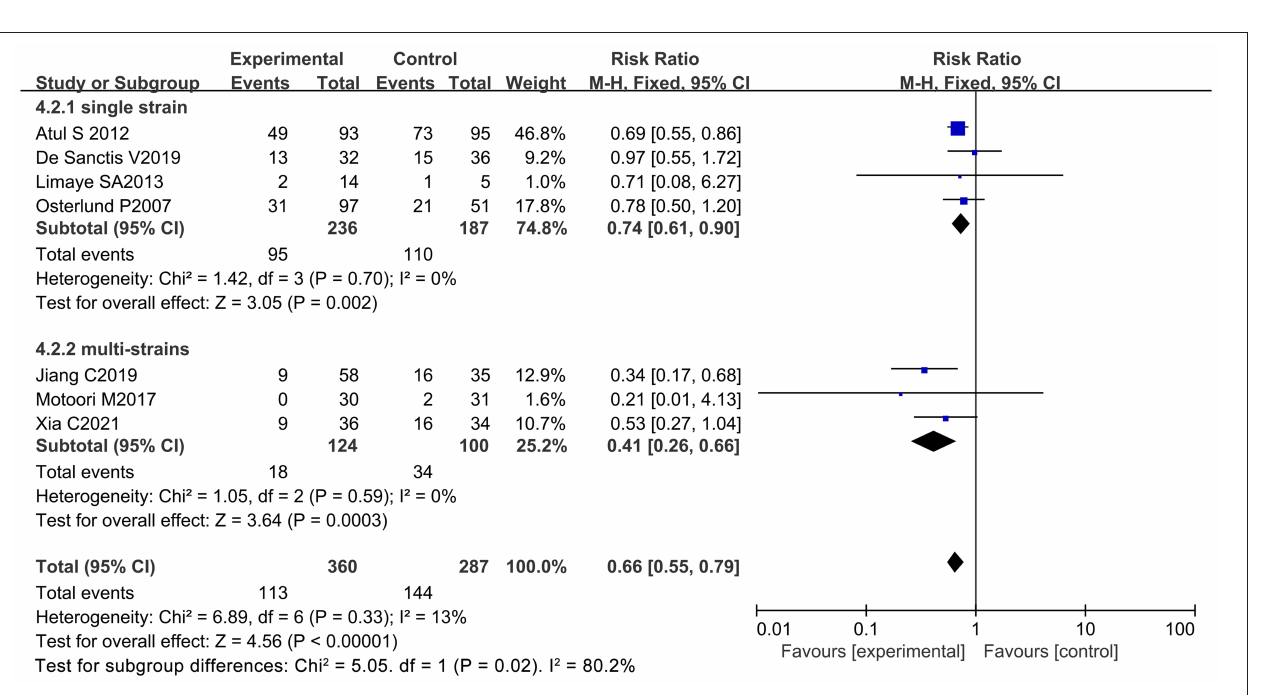
FIGURE 13 | Subgroup analysis of the effect of bacterial number on the incidence reduction of severe oral mucositis in cancer